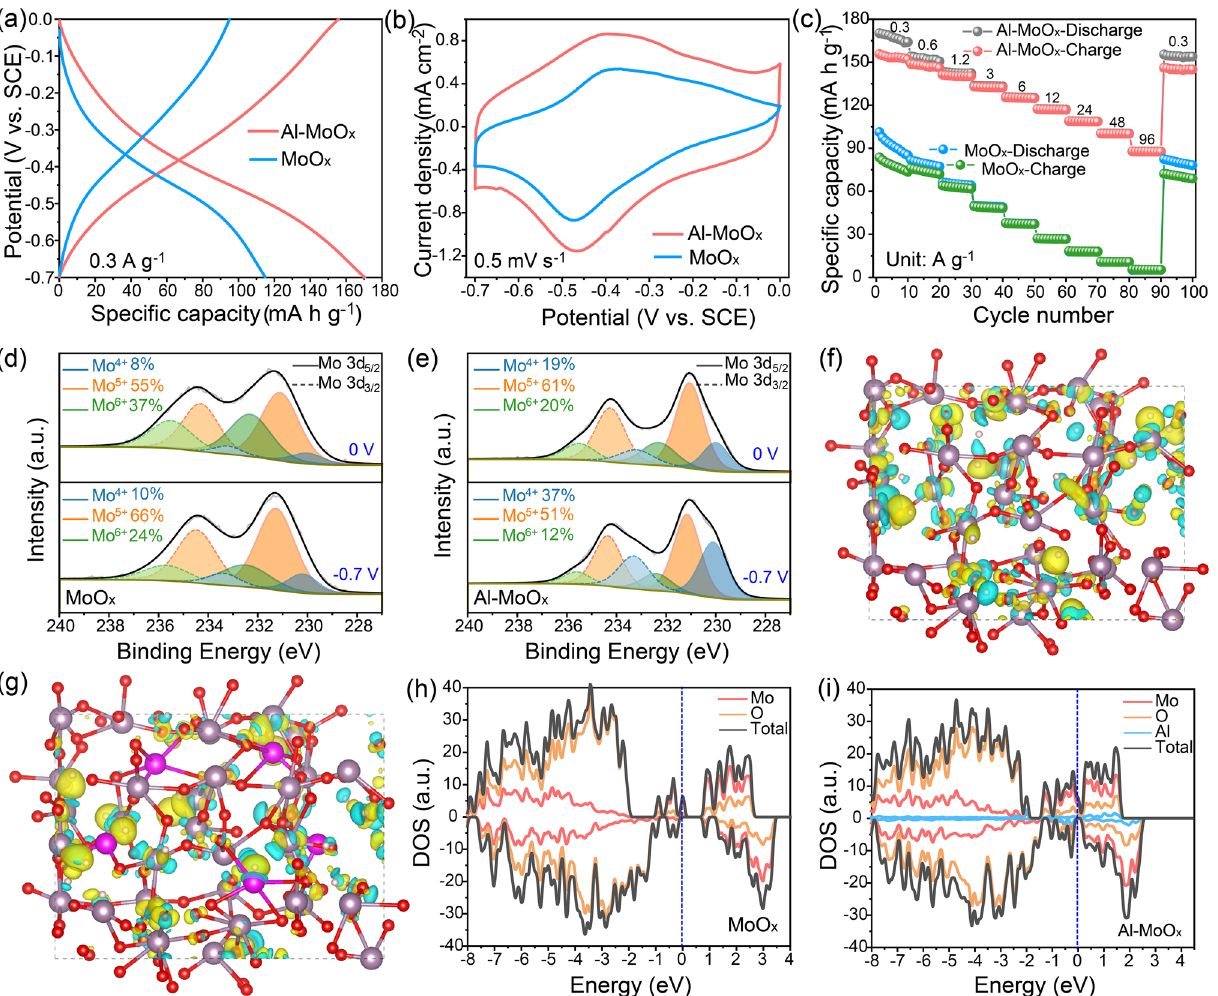
Fig. 3 Hydrogen-ion storage performances and mechanism. a GCD curves at 0.3 A g −1 , b CV curves at 0.5 mV s −1 and c rate capability of MoO x and Al-MoO x . Mo 3 d XPS spectra of different charge states of d MoO x and e Al-MoO x . Differential charge density of hydrogen-ion inser- tion in f MoO x and g Al-MoO x . The yellow and cyan regions refer to electronic charge accumulation and depletion. The gray, red, purple, pink and white balls refer to Mo, O, K, Al and H atoms, respectively. Density of states for h MoO x and i Al-MoO